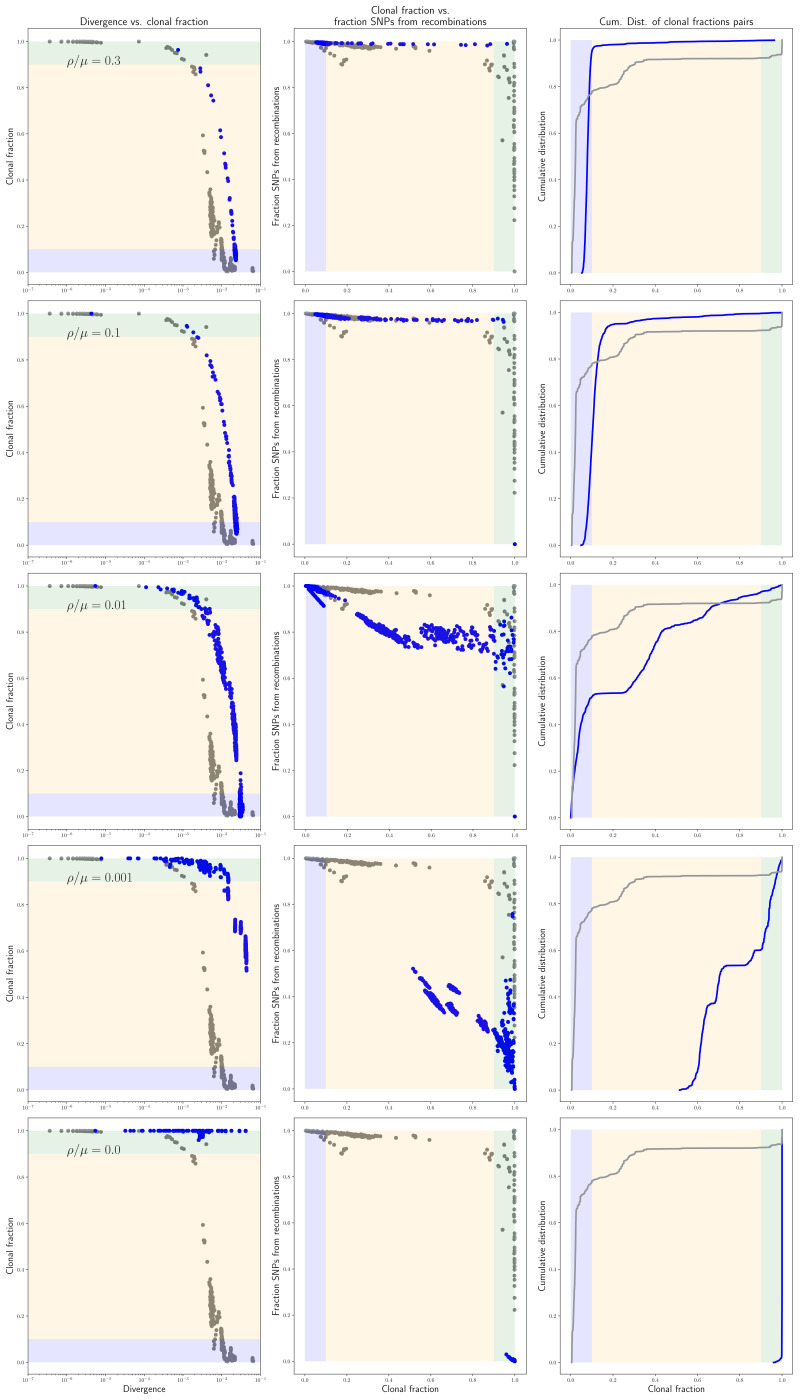
Statistics of the pairwise analysis on the simulated data. Each row of panels corresponds to simulations performed with a different recombination rate (indicated in each row) and shows, in blue, the same results as in panels G, H, and I of Figure 2, that is the fraction of the genome that was clonally inherited as a function of divergence for each pair, the fraction of all mutations that derive from recombination as a function of the clonally inherited fraction, and the cumulative distribution of clonally inherited fractions. For reference, the corresponding results for the E. coli strains are shown in gray.